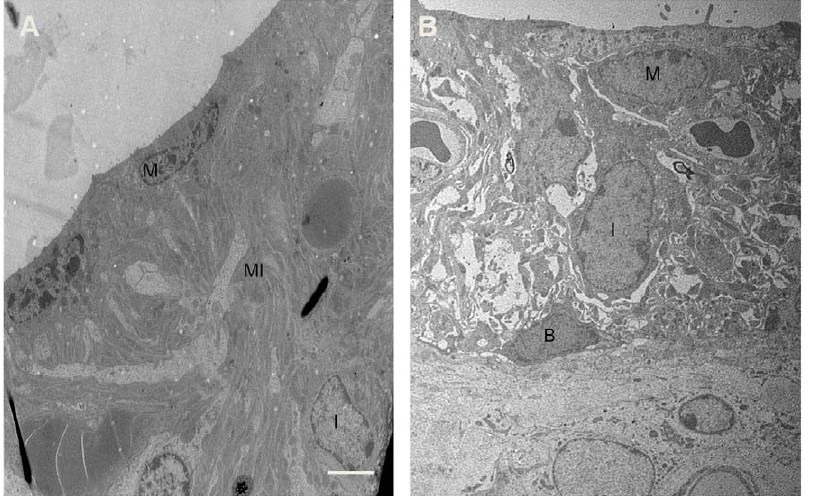
Figure 6. Transmission electron micrographs of the stria vascularis in Slc26a4 + / + mice (A) and Slc26a4 tm1Dontuh/tm1Dontuh mice (B). The most significant change in stria vascularis in Slc26a4 tm1Dontuh/tm1Dontuh mice was diminished membrane invaginations of marginal cell with vacuolization changes. B, basal cell; I, intermediate cell; M, marginal cell; MI, membrane invaginations. Bar=5 m m.